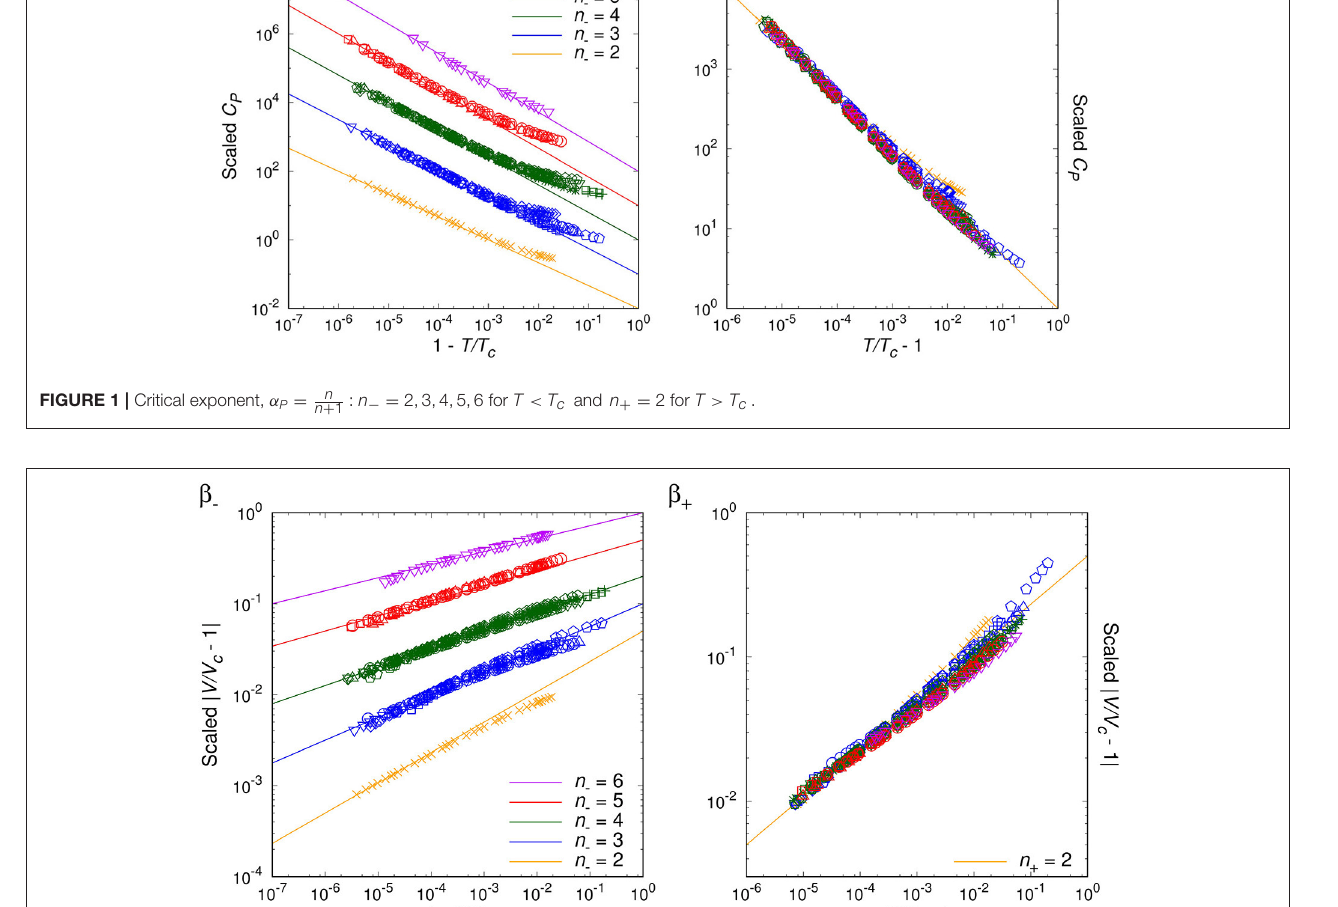
Frontiers in Physics |